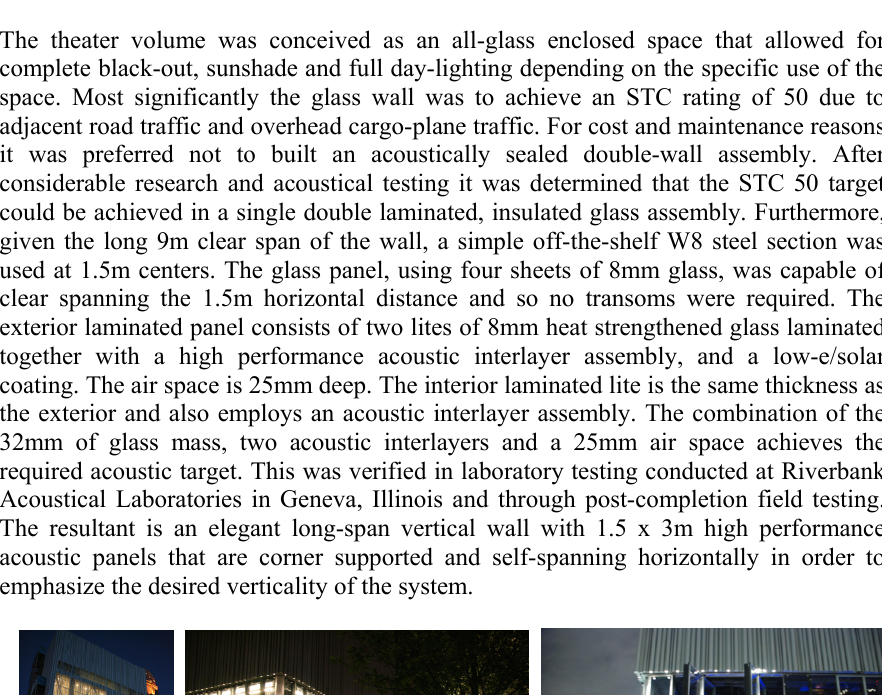
Figure 7a, b, c: Wyly Theater, Glass Wall Detail, Theater Interior.